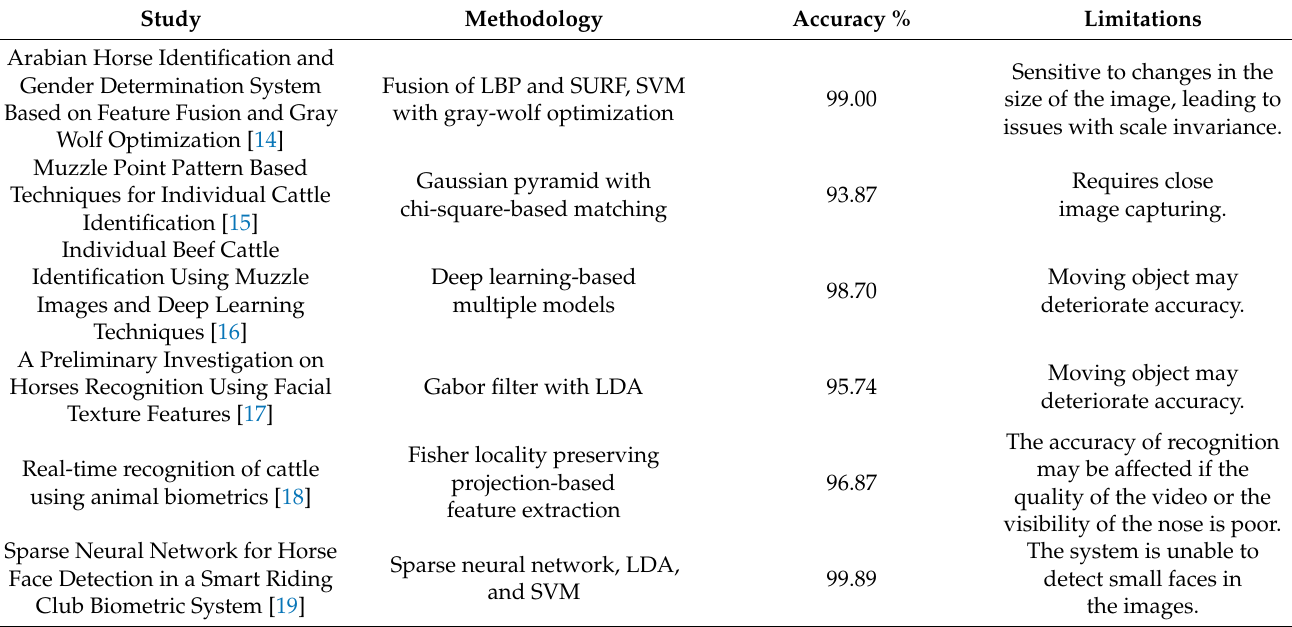
Table 1. Comparison and limitations of previous